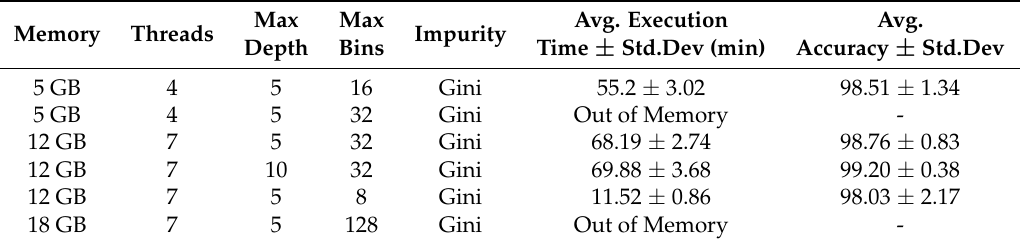
Table 8. Decision Tree classifier performance on the BRCA dataset with ten different randomly generated training (80%) and test (20%)